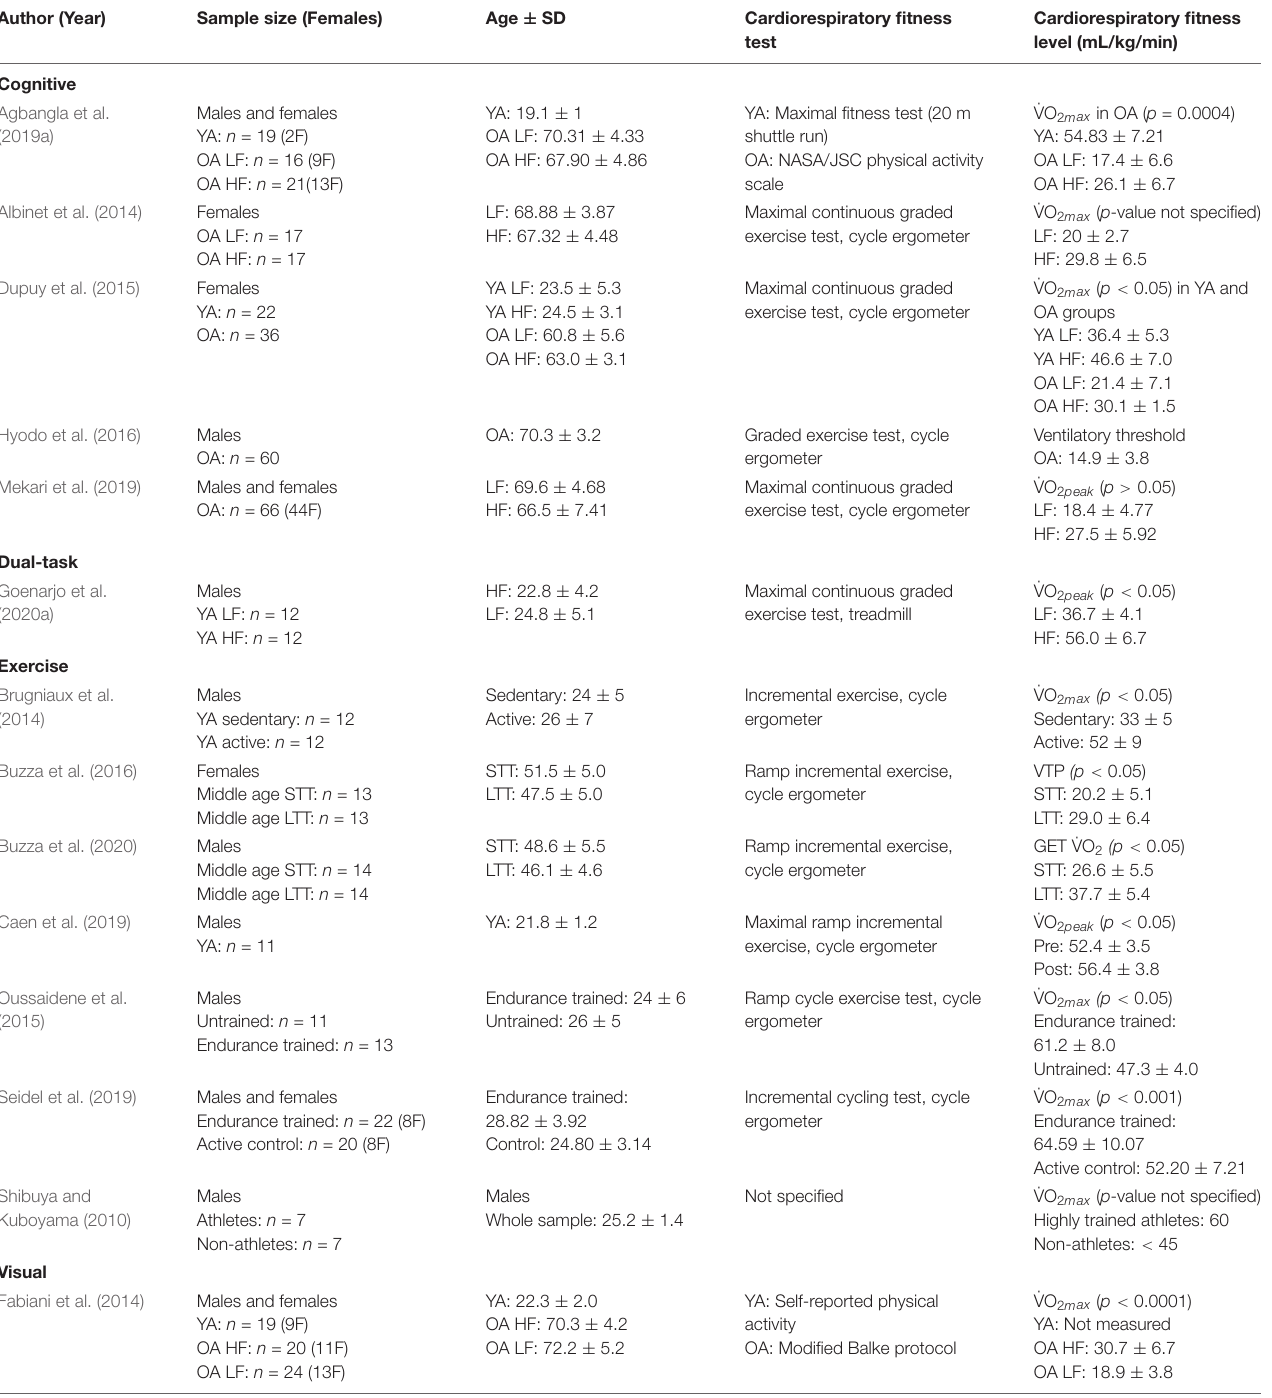
TABLE 2 | Participant characteristics for included studies.